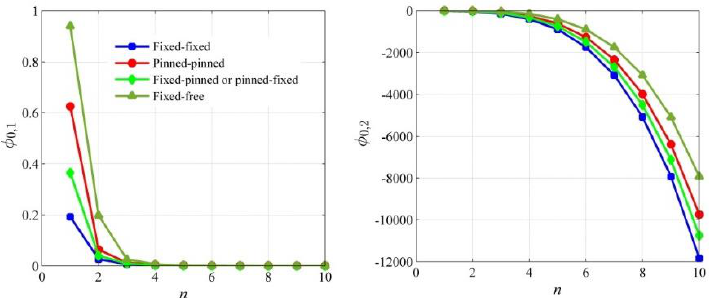
Figure 4. Mode amplitude ratios in two sub-modes versus the order of basic mode for different boundary conditions when s e = 100, s m = 1 and s k = 2.